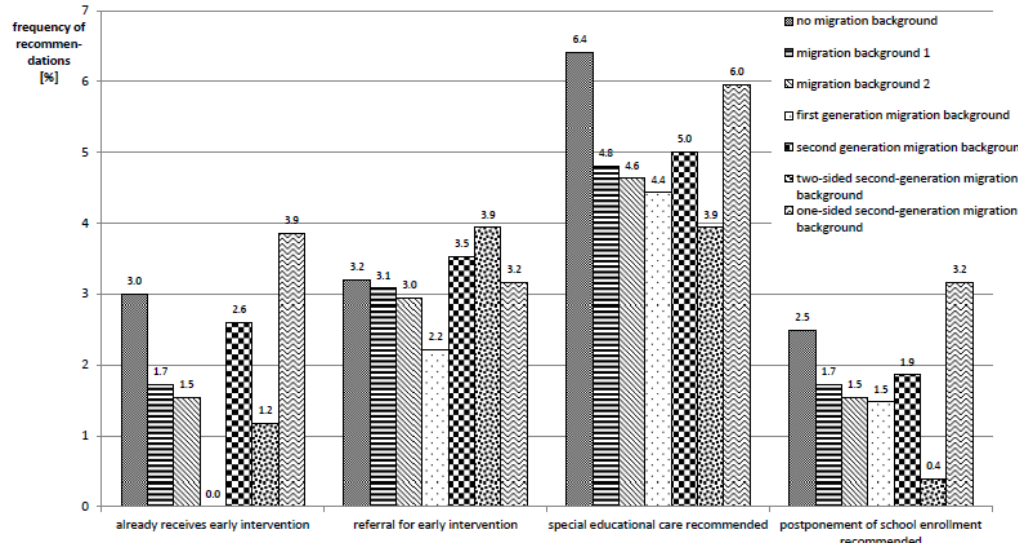
Figure 4. Frequencies of recommendations in relation to developmental delays, stratified according to migration status.